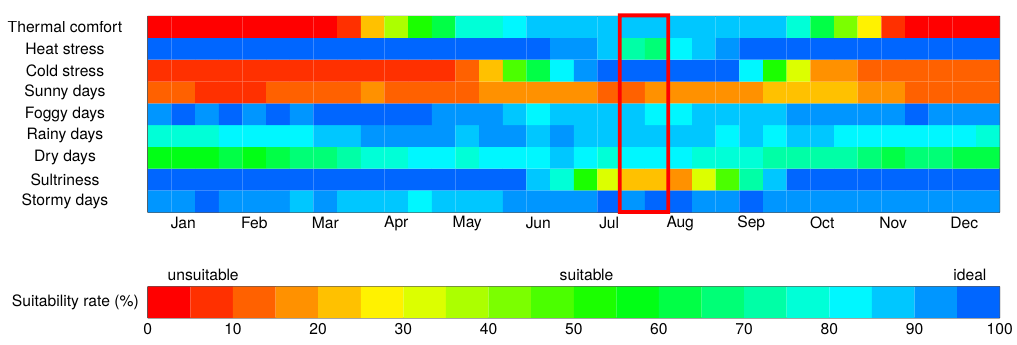
Figure 7. “Climate-Tourism/Transfer-Information Scheme” (CTIS) for Sapporo. The red lined box highlights the scheduled time for the Olympic Games 2020. The suitability rate defines the suitability of each category for tourists per an approximate decadal resolution.